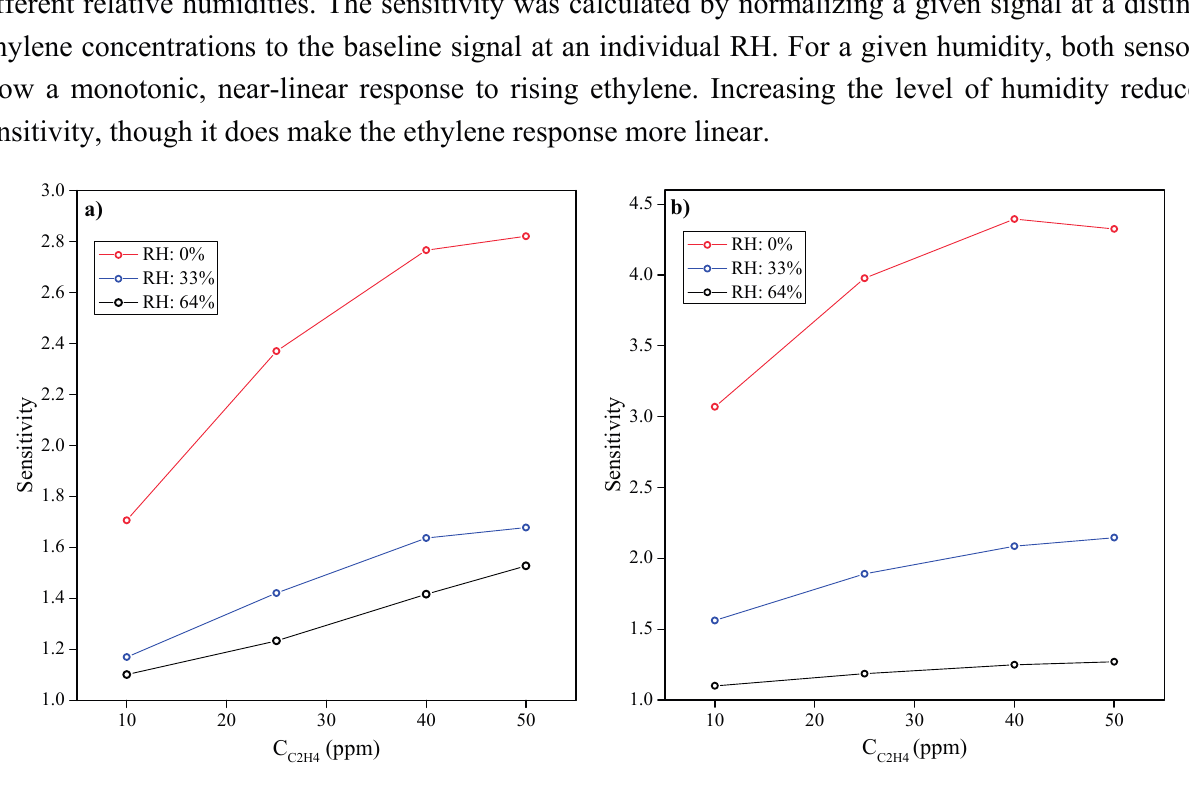
Figure 4. Sensitivities of the ( a ) MQ-3 sensor and ( b ) MiCS-5914 sensor to different ethylene concentrations at different relative